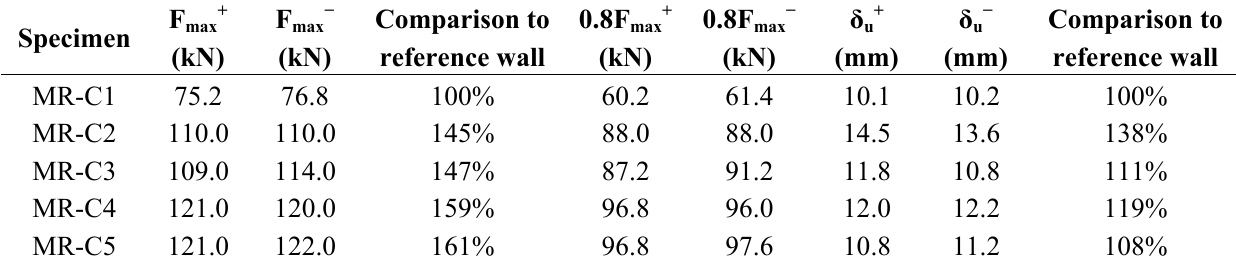
Table 3. Horizontal force and maximum displacement at the top of the wall in Series